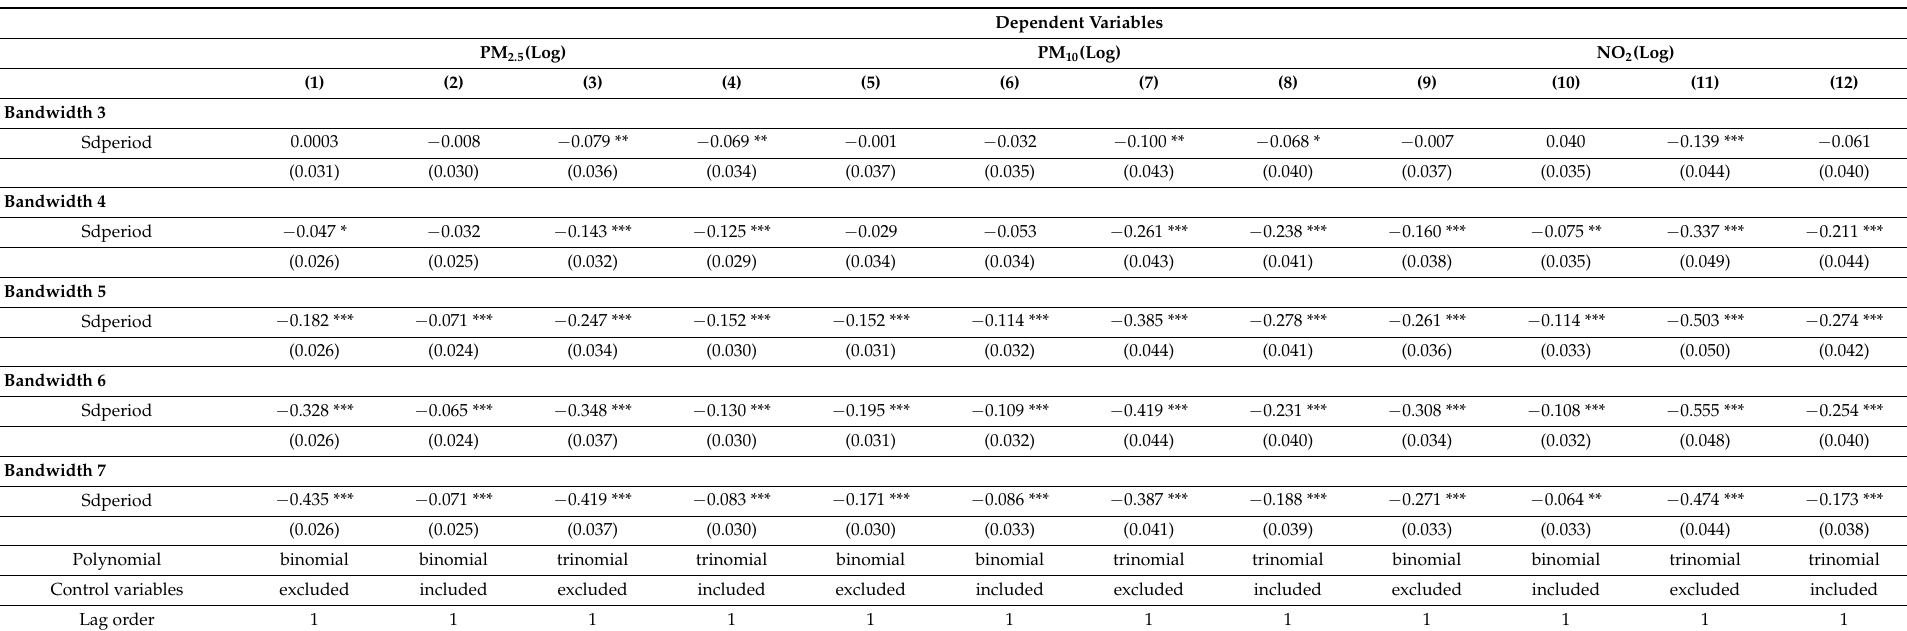
Table 3. Regression discontinuity